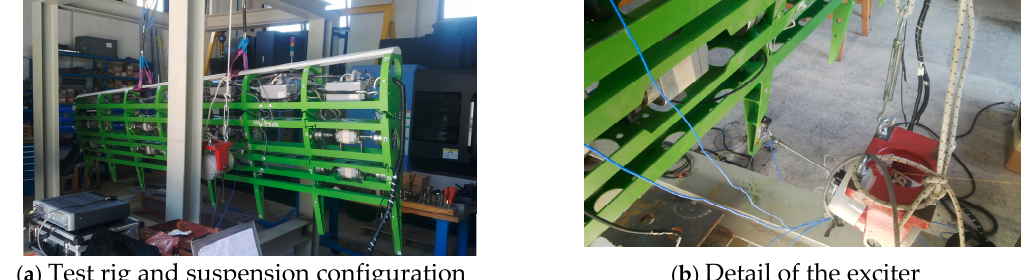
Figure 23. Boundary conditions of the GVT.